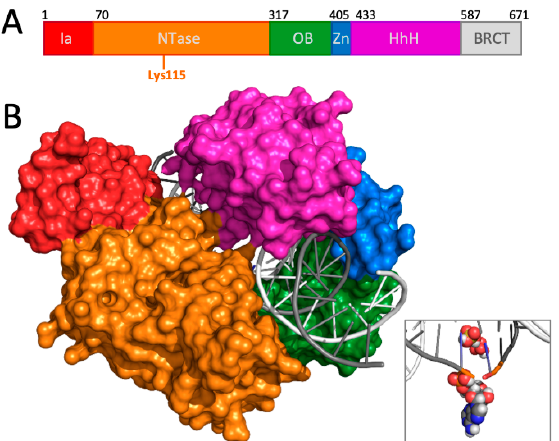
Figure 1. E. coli DNA Ligase A. ( A ) A schematic of the domain architecture of EC-LigA. From N- to C-termini (left to right) these are: Ia (N-terminal domain), NTase (nucleotidyltransferase), OB (oligomer binding OB-fold), Zn (zinc finger), HhH (helix-hairpin-helix) and BRCT (BRCA1-like C-terminus). The starting residue number of each domain is indicated above and the approximate location of the essential AMP-transfer residue (lysine 115) is indicated below. ( B ) Structure of EC-LigA (surface view) bound to a 26 bp nicked DNA-adenylate (cartoon) (PDB 2OWO, [16]), with domains coloured as in Panel A. The BRCT domain was not visible in the crystal structure. The inset shows a close-up of the nick site, with the 5 ′ -phosphoryl-AMP group (spheres: grey, carbon; red, oxygen; blue, nitrogen; white, hydrogen) on the DNA poised for nick-closure.